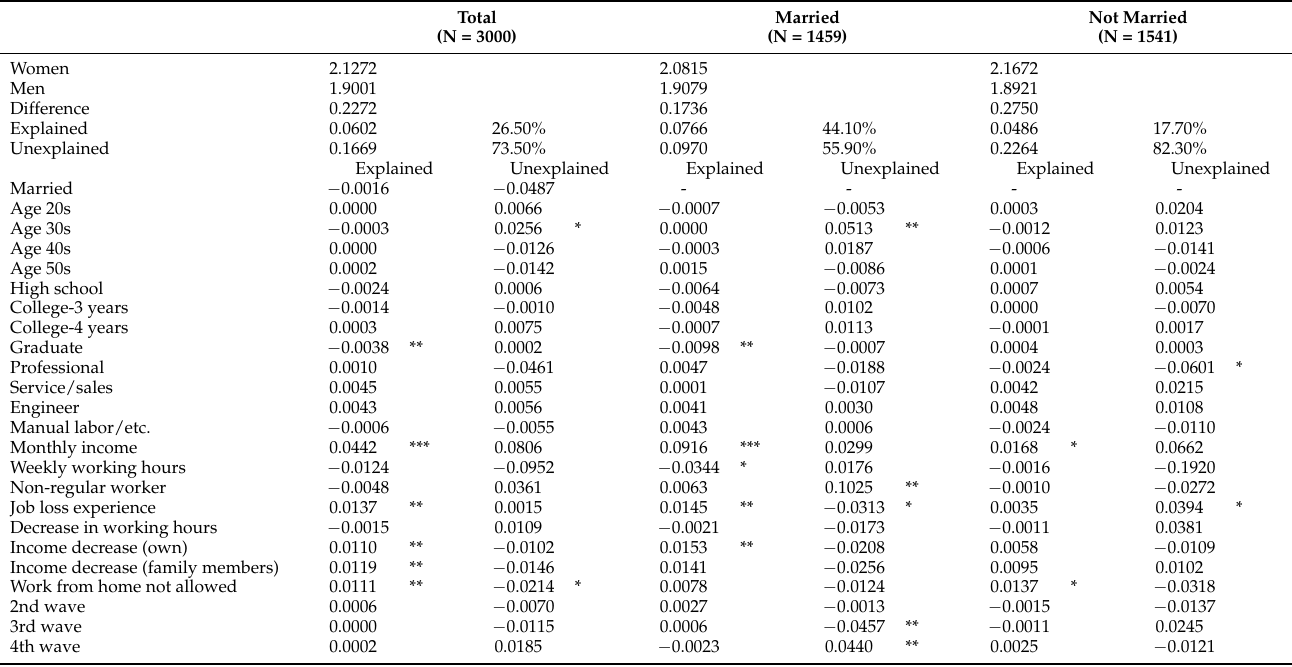
Table 3. Blinder-Oaxaca decomposition of the gender gap in